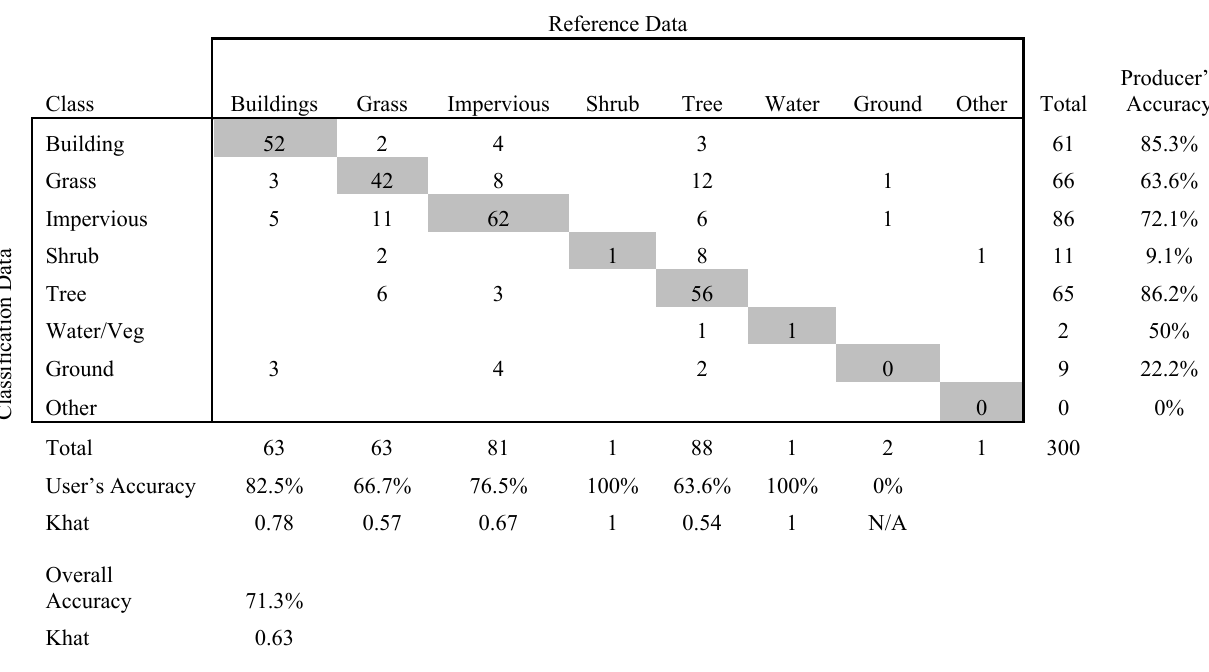
Table 4. Accuracy Assessment Confusion Matrix for Case Study